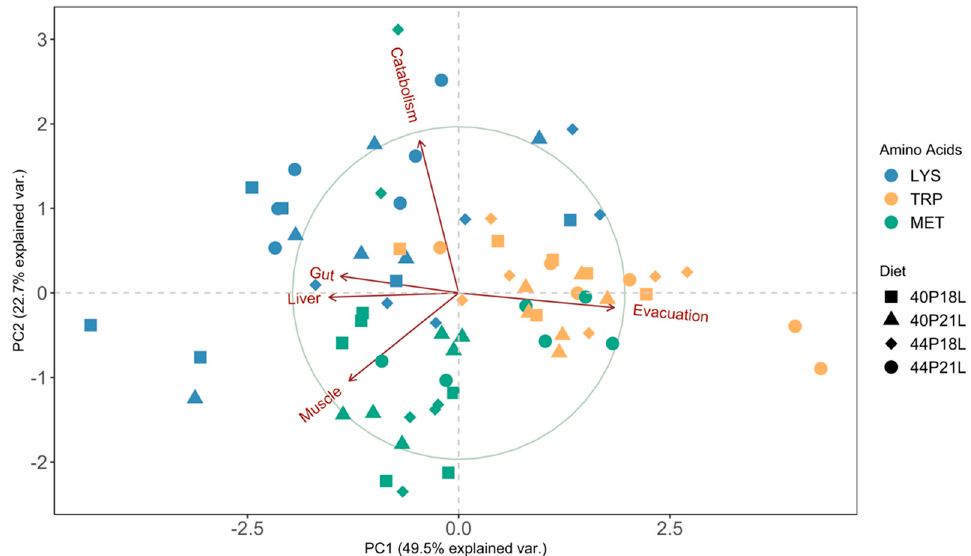
Figure 3. Principal component analysis (PCA) of the metabolic flux assays data generated by gilthead seabream juveniles fed different diets (44P21L, 44P18L, 40P21L, and 40P18L) labelled with 14 C-amino acids lysine (LYS), tryptophan (TRP), and methionine (MET). Each point represents the projection of an individual sample in the PC1 and PC2 axis. Each dietary treatment is identified by a unique shape and each 14 C-amino acid as a unique colour, as indicated in the legend.